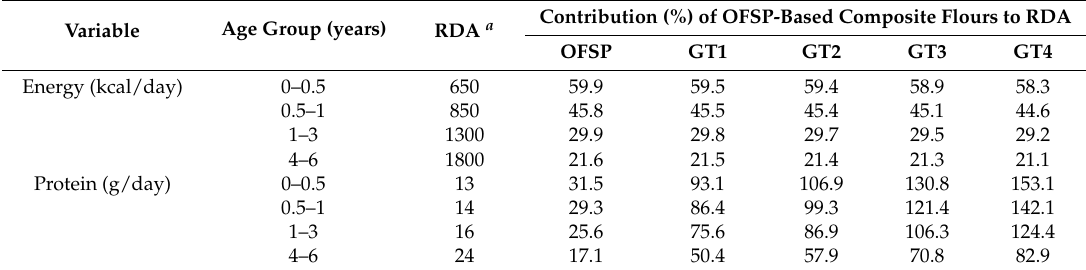
Table 4. Contribution (%) of energy and protein content of porridge from 200 g of OFSP-based composite flours in 800 mL of water towards RDA for children aged 6–59